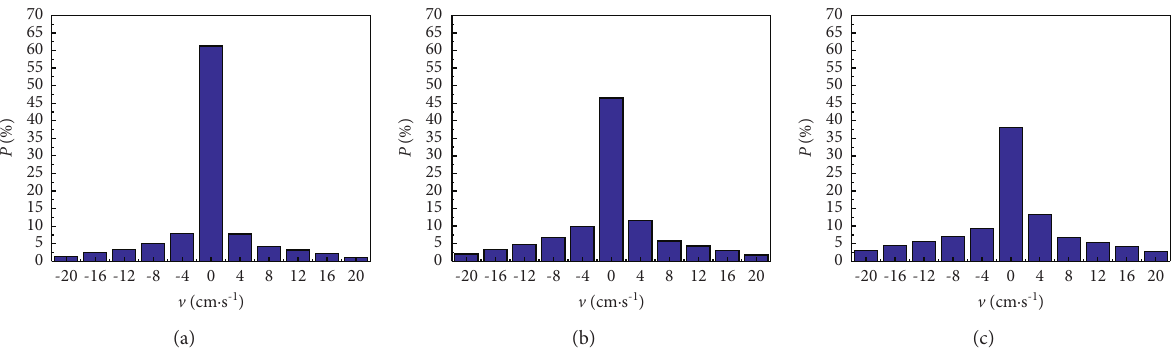
Figure 6: The probability distribution of vertical pulsation velocity in different working conditions. (a) B25S. (b) B25M. (c)